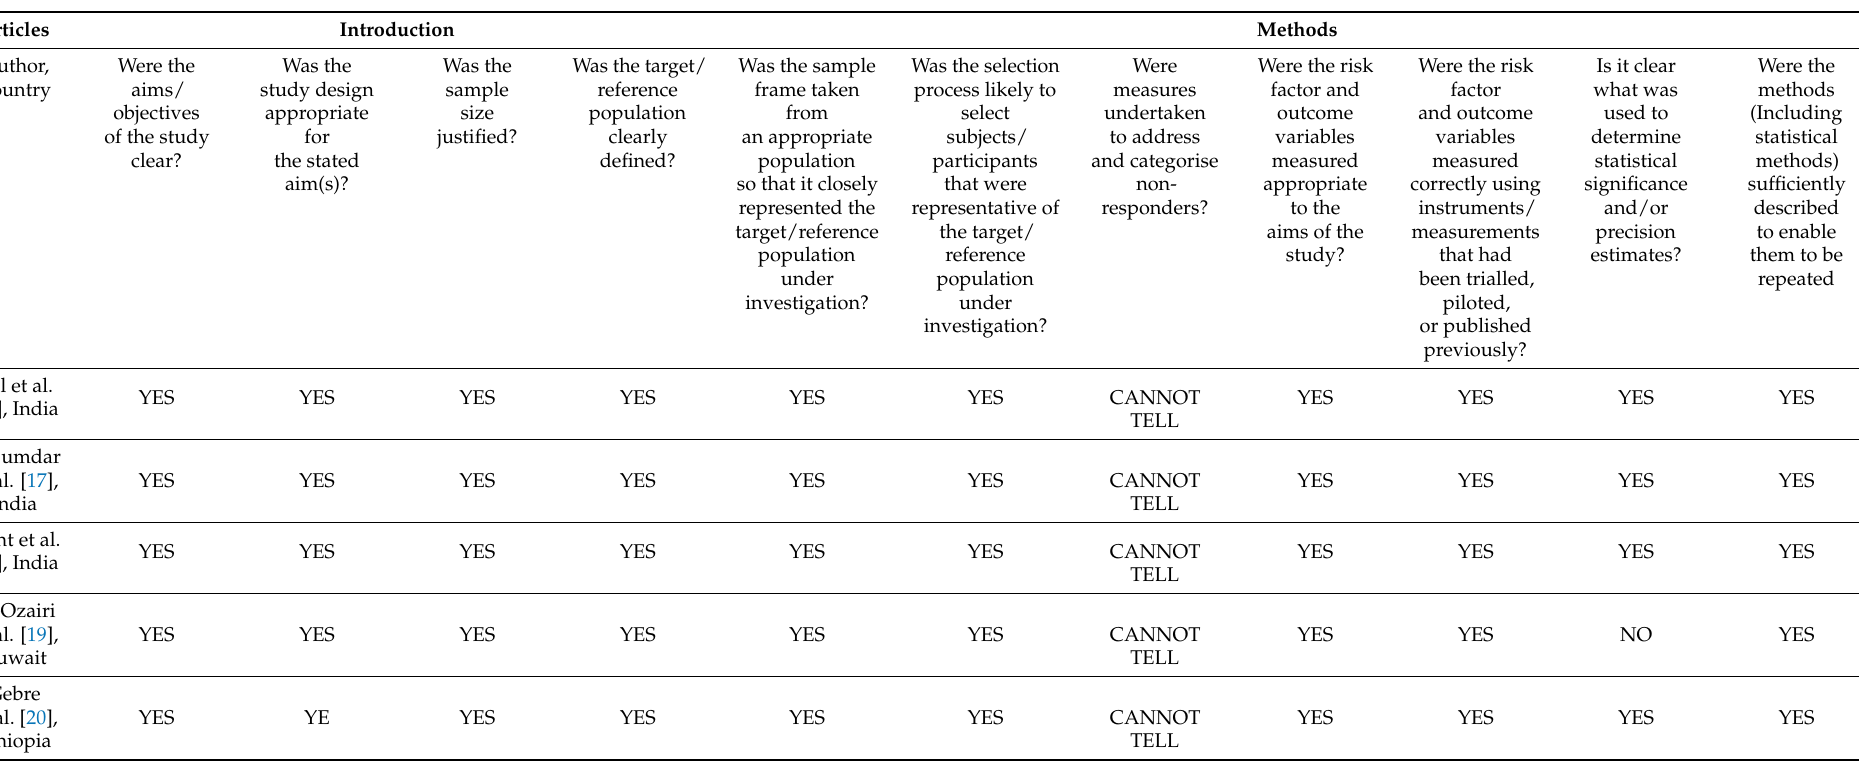
Table A1. Quality assessment of included studies using the AXIS